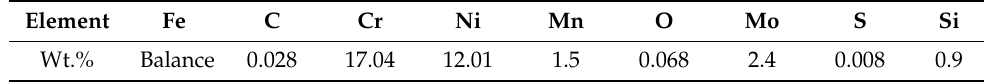
Table 1. Composition of 316L stainless steel